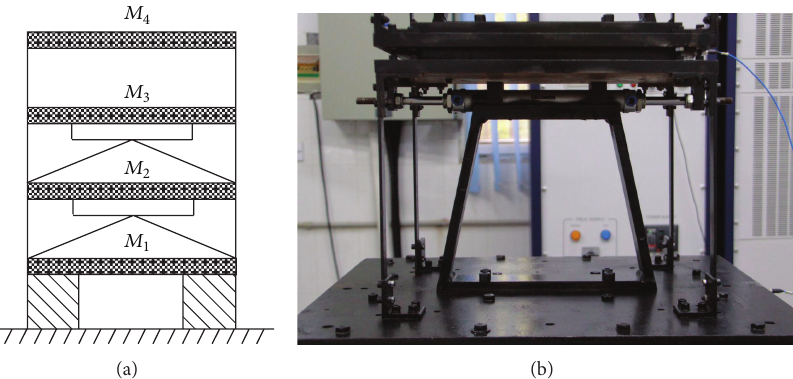
Figure 3: A base-isolated building model equipped with two stiffness element devices in the second and third stories: (a) schematic figure and (b) actual installation in the second story.